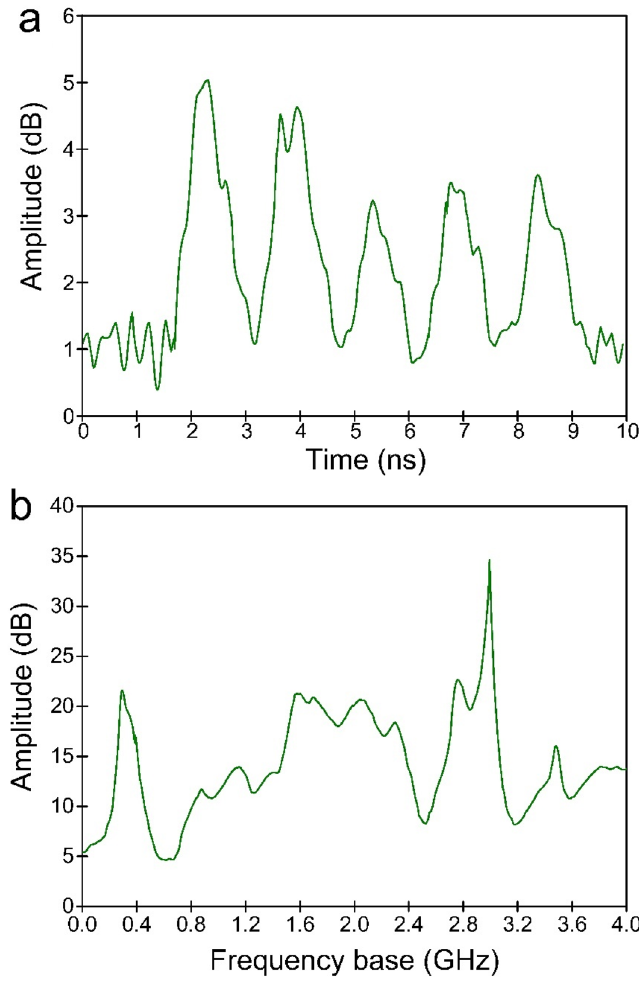
Figure 7. Results of the microwave emission study in opal matrix arising under laser impact; ( a ) typical oscillogram from spiral antenna; ( b ) power spectrum from spiral antenna.